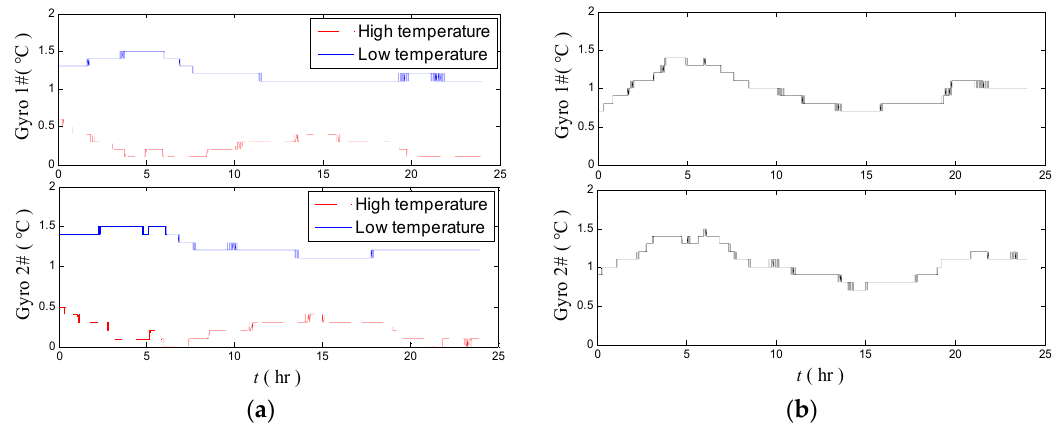
Figure 7. Temperature fluctuation of the gyros in the high–low temperature tests ( a ) and the temperature fluctuation difference of the gyros under high and low temperature tests ( b ).